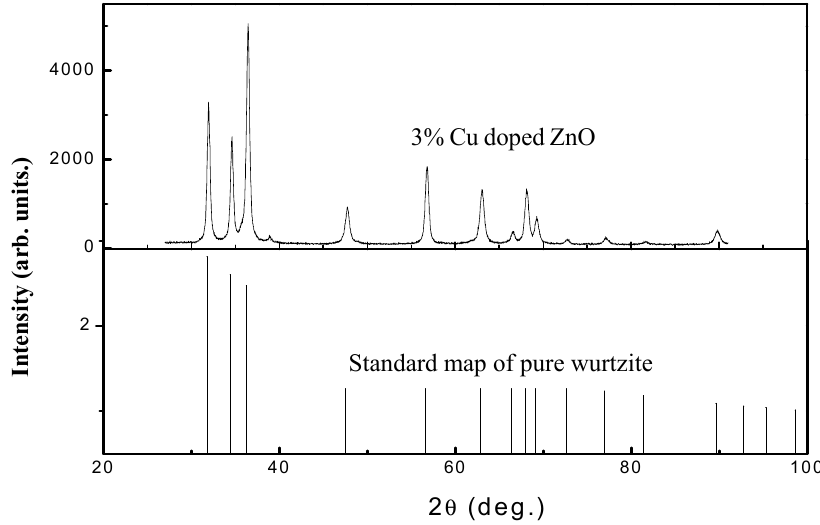
Figure 2. XRD patterns of Cu/ZnO (3% Cu) and standard pure wurtzite.